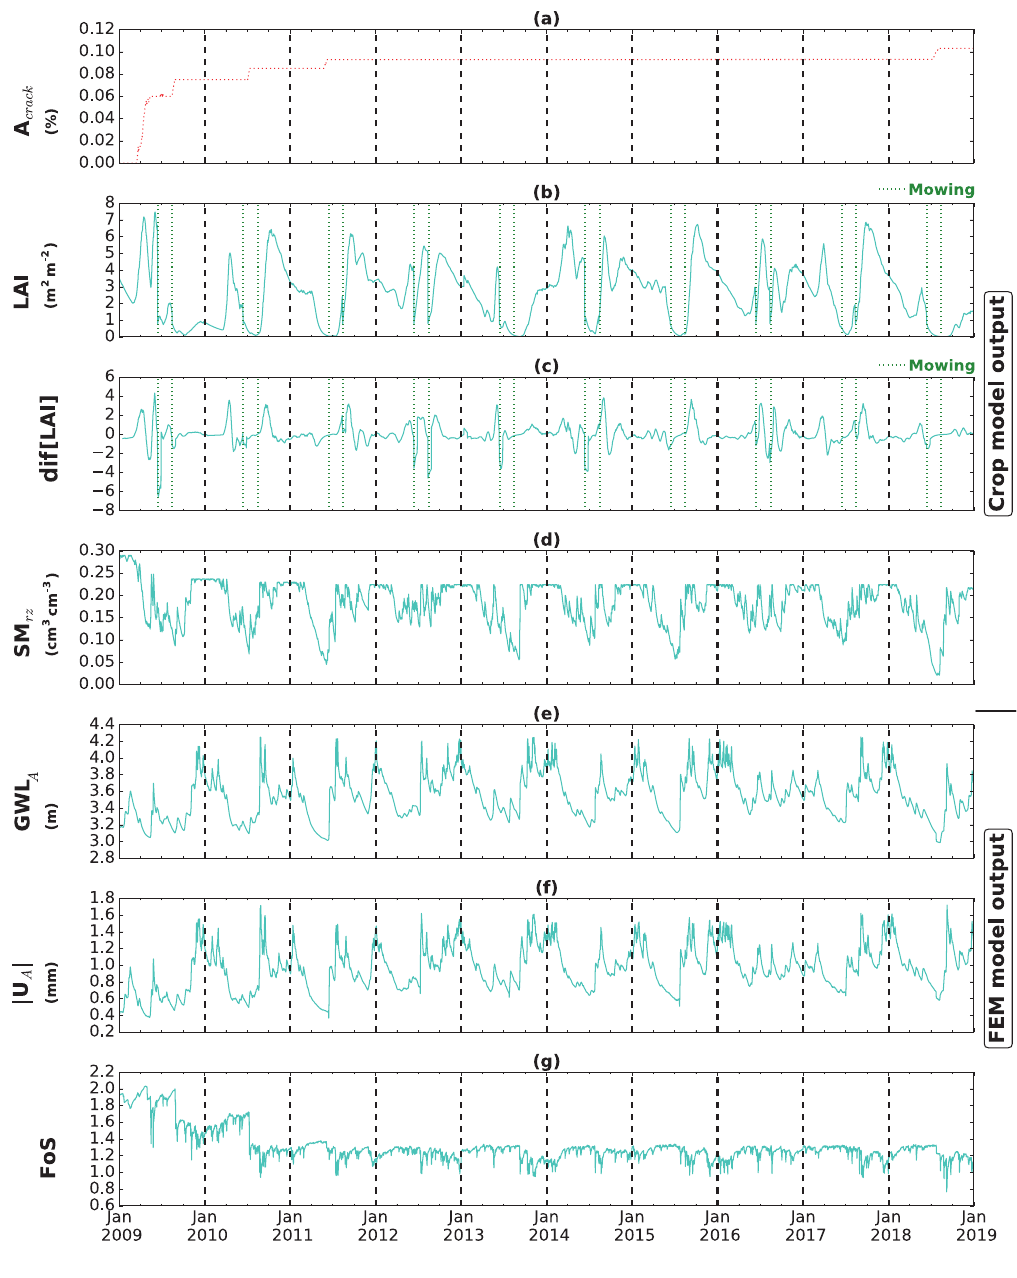
Figure 6. Time series outputs from the coupled model for 10 years; ( a ) crack area percentage ( A crack ); ( b ) Leaf Area Index ( LAI ); ( c ) rate of LAI change over 15 days ( dif [ LAI ] ); ( d ) average soil moisture in the root zone ( SM rz ); ( e ) ground water level at point A ( GWL A ); ( f ) magnitude of total displacement at point A ( | U A | ); ( g ) Factor of Safety